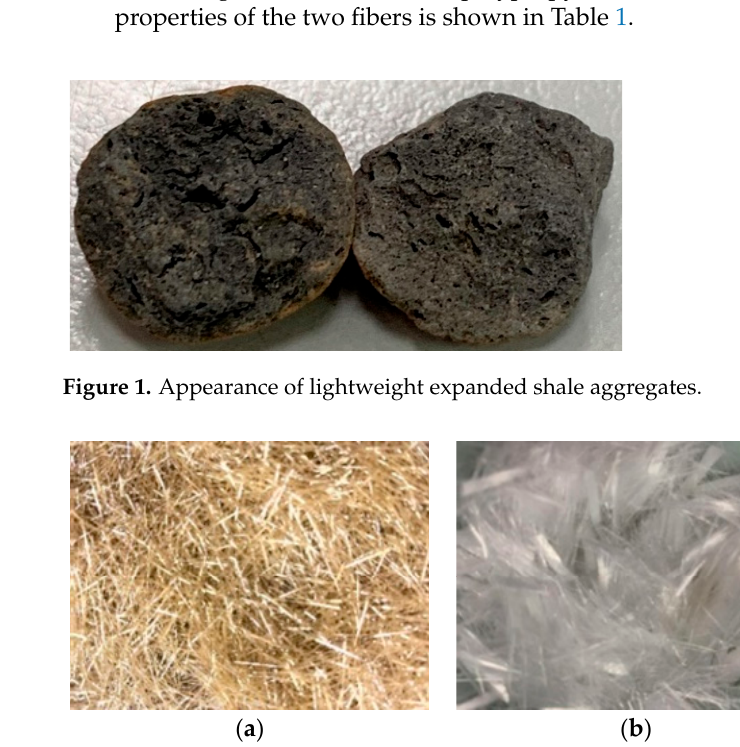
Figure 2. Fibers used in this study: ( a ) short micro-steel fibers; ( b ) polypropylene fibers. Table 1. Basic physical and mechanical properties of fibers.